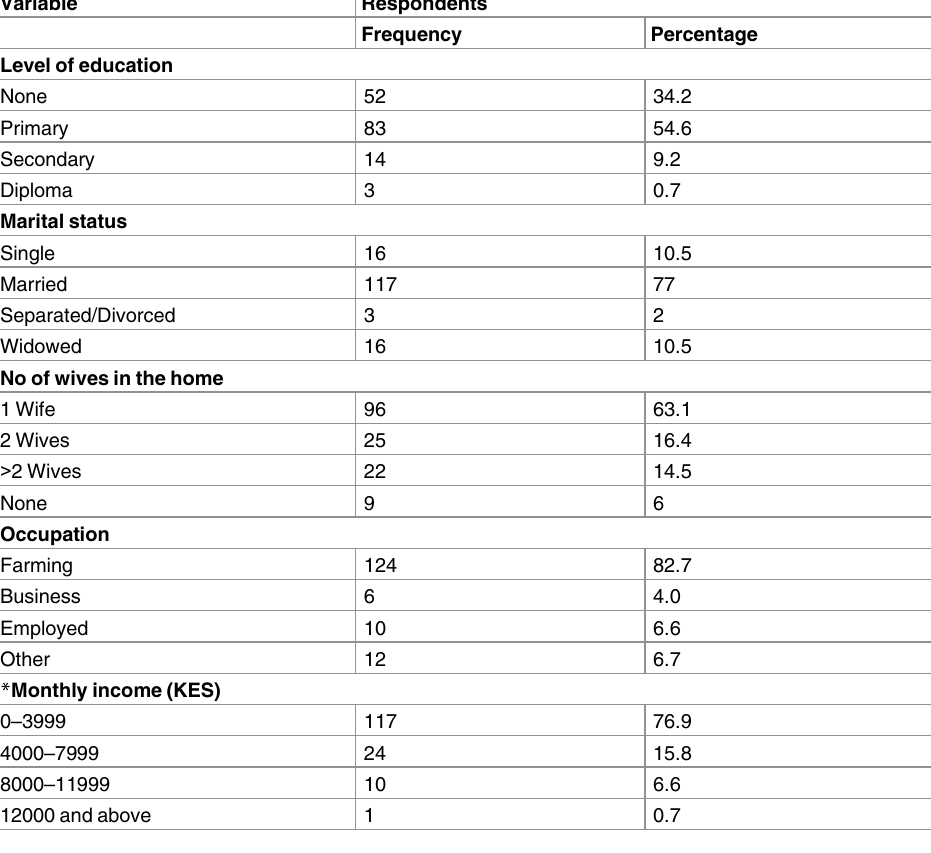
Table 1. Socio-demographics of HAT patients in the south western Kenya HAT foci (1990–2002) (n = 152).